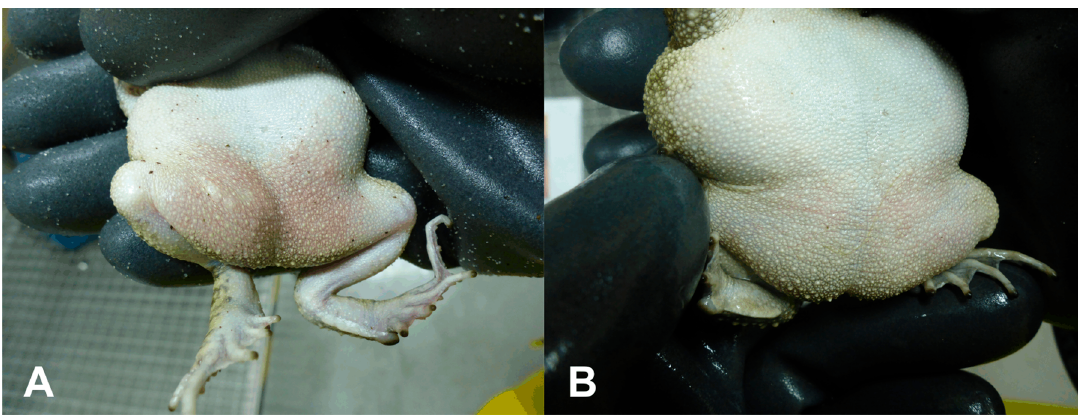
Figure 2. Hyperemia in ZH501-infected toads. ( A ) ZH501-infected toad (#K28-Z) at 16 dpi with mild hyperemia, apparent through reddened skin at the lower abdomen and hind legs; ( B ) non-infected toad (#K30-Z) at 16 dpi.